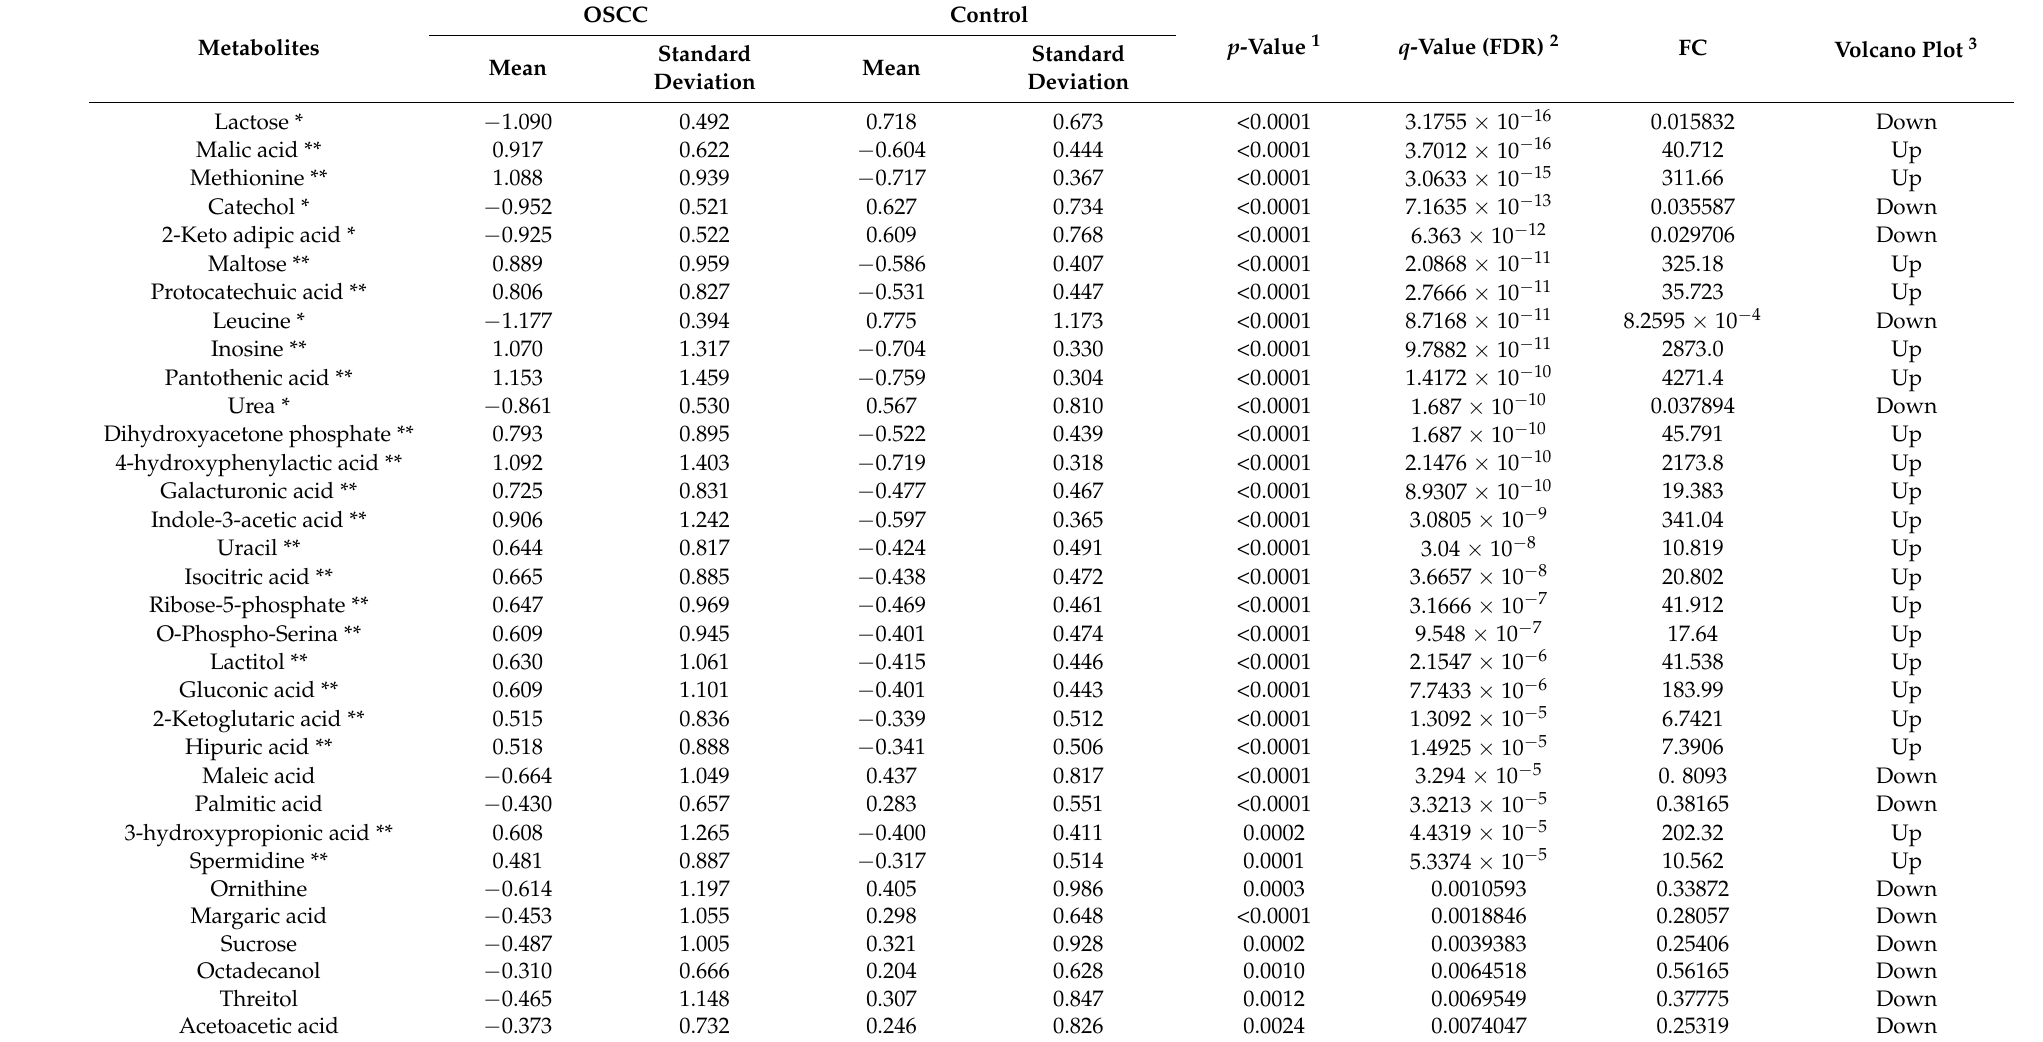
Table 4. Set of metabolites up- and down-regulated in OSCC samples according to PCA